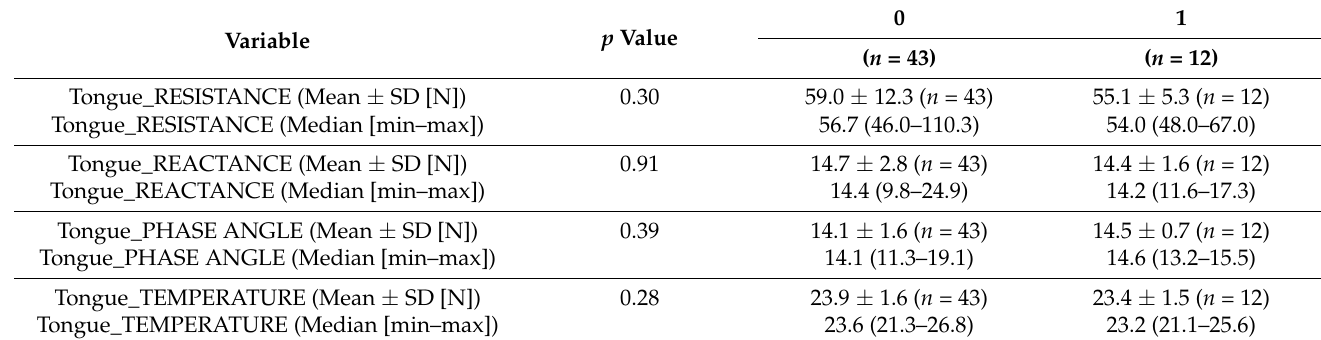
Table 5. Comparison between measurements in different types of lesion in OLP patients (tongue), classified as: no lesions = 0; striations = 1; erythema or erosion = 2. Electrical values are in Ohm. 1 = Wilcoxon’s rank-sum